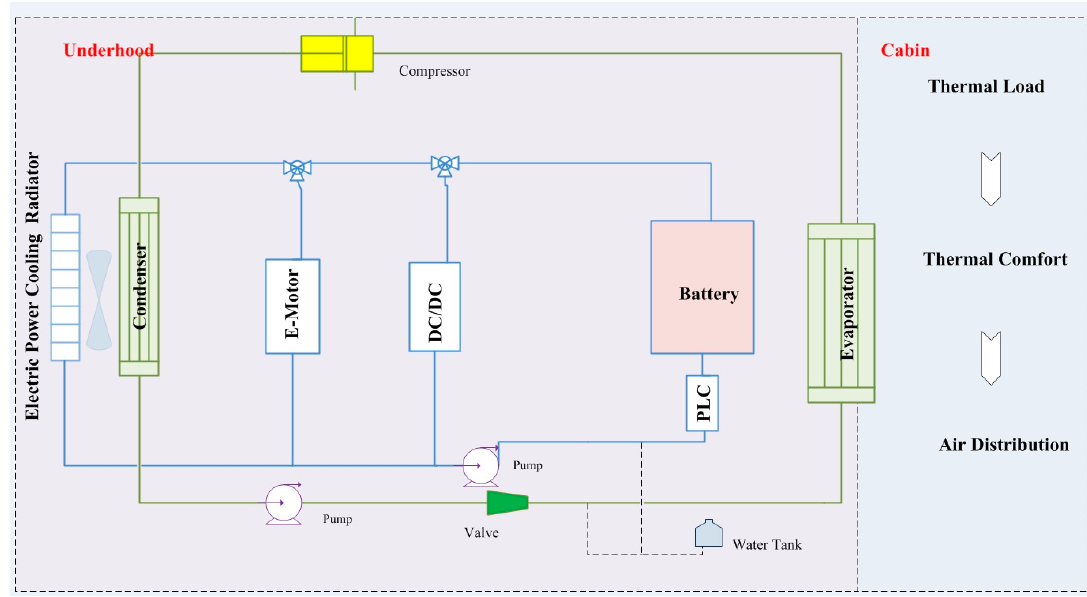
Figure 3. Typical thermal management schematics diagram of pure electric vehicle (PEV).